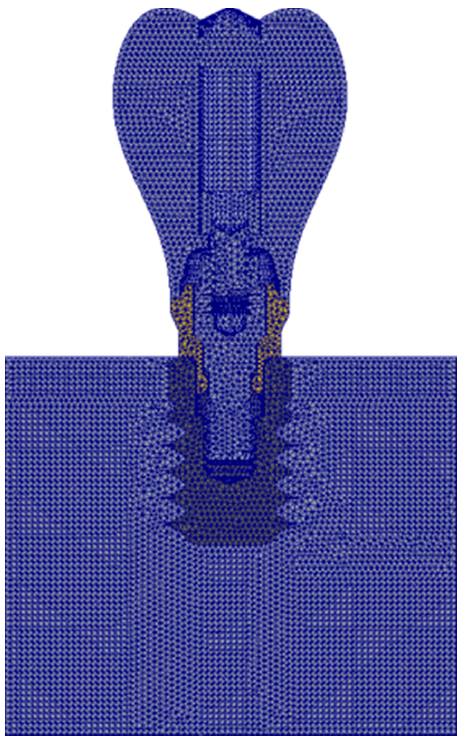
Figure 4. Finite element model mesh.